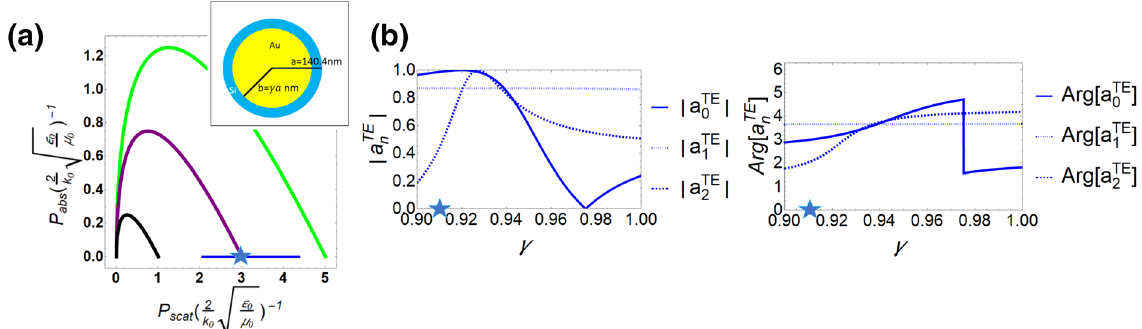
Figure 4. ( a ) Power distribution of a gold-silicon shell-core system by tuning ratio of inner to outer radius, γ , is shown in blue line. Here we ignore the material losses, but the real part of permittivities are based on data 38 . With outer radius of 140.4 nm and operating wavelength of 500 nm, we tune ratio of inner to outer radius γ from 0.9 to 1. In a blue star, the system can display a superscattering property for N = 1 . The magnitudes